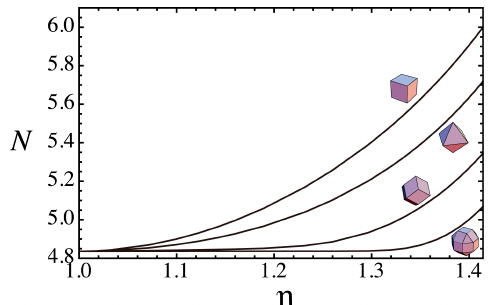
Figure 3. The relationship between N = A / V 2/3 and η for the hexahedral, octahedral and dodecahedral superspheres respectively given by Equations (3)–(5) and rhombicuboctahedral (RCO) supersphere given by Equation (6) with a = 2 2 − 1 and b = 2 . The results for the superspheres are shown with insets of the polyhedral shapes when η = 2 .